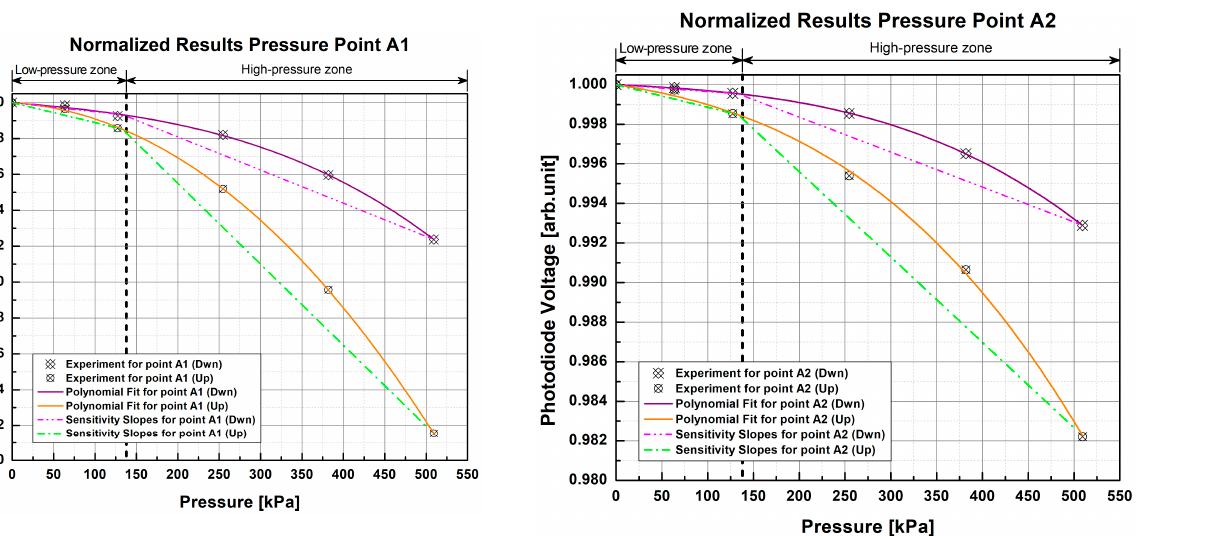
Figure 7. Normalized response curves of the 1 POF × 1 POF sample with the scientific-grade equipment setup for pressure point A1. The experimental data points correspond to the average of two test repetitions.